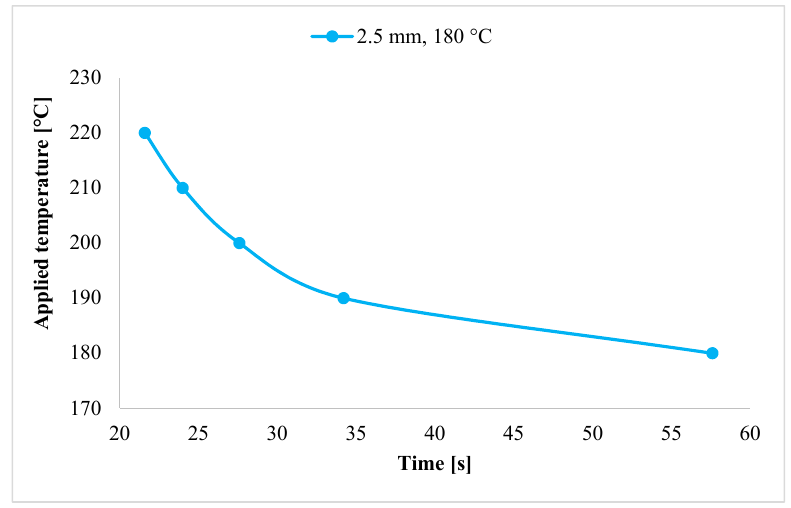
Figure 4. Time to complete a heat transfer of 180 °C, with differing applied temperatures, for a composite thickness of 2.5 mm.